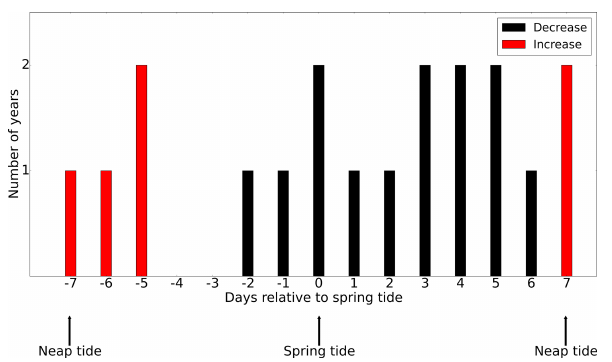
Figure 11. The occurrence of an increase (red) or decrease (black) in the NPP difference (tidal scenario (M 2 + S 2 ) − M 2 tidal sce- nario) relative to the nearest spring tide (spring and neap phase indi- cated). The development of the spring bloom period is defined as the time when NPP increases from 12.5% to 87.5% of the maximum NPP prior to the major peak of the spring